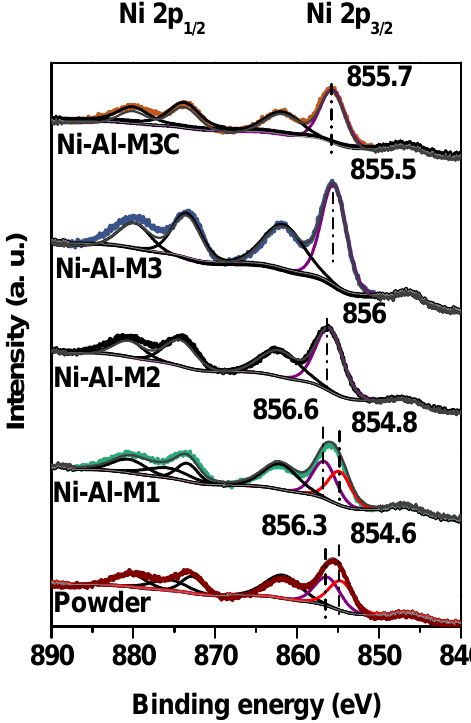
Figure 6. XPS spectra in the Ni 2p region of all the structured catalysts and the powder catalyst.